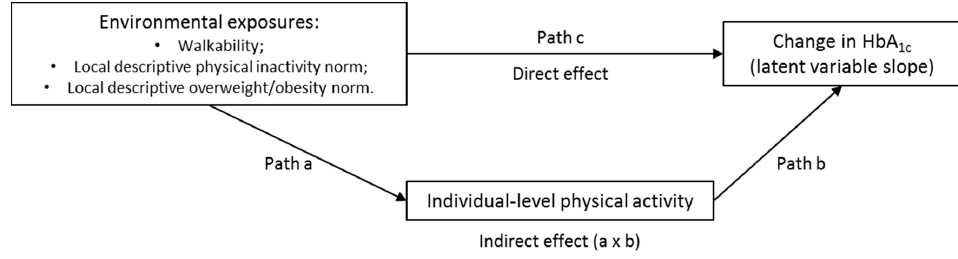
Figure 2. Path model representing hypothesized direct and indirect effects of environmental exposures on change in glycosylated hemoglobin (HbA 1c ).